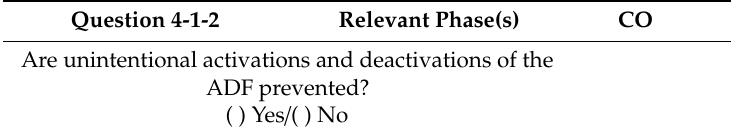
Table 4. ExamplequestionHuman–VehicleIntegration(HVI)guidelines. ADF:AutomatedDrivingFunction.